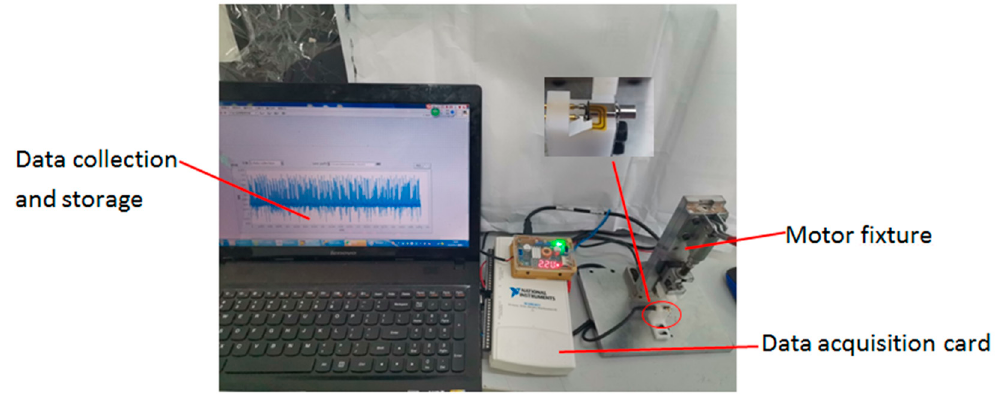
Figure 15. Data acquisition chart.